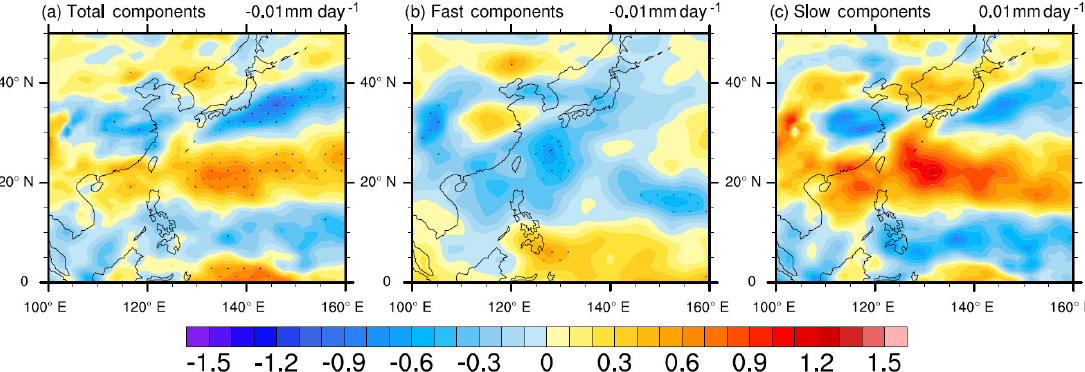
Figure 12. JJA mean total, fast, and slow responses of precipitation rate to BC forcing (unit: mmday − 1 ) . The values in the top right corner of the figures represent the responses averaged over the region 0–50 ◦ N, 100–140 ◦ E. The dots represent significance at ≥ 95% confidence level from the t